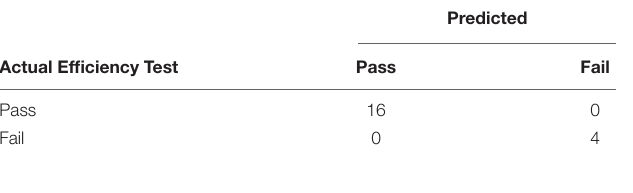
TABLE 2 | The confusion matrix of the 3D Quality Control System (QCS) classification